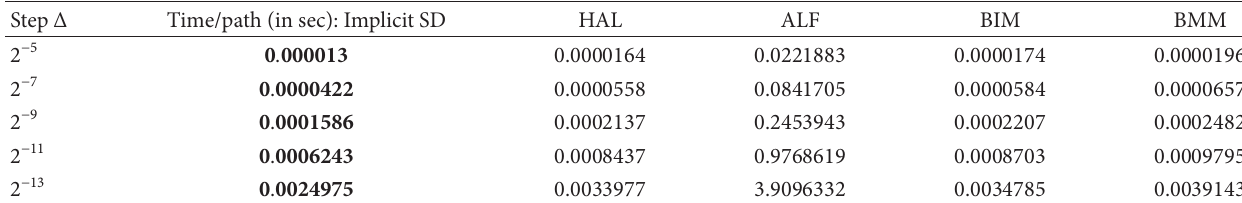
Table 2: Average computational time (in seconds) for a path, for different discretizations, for all considered positivity preserving methods for the mean-reverting CEV process (2) with 𝑞 = 3/4 .